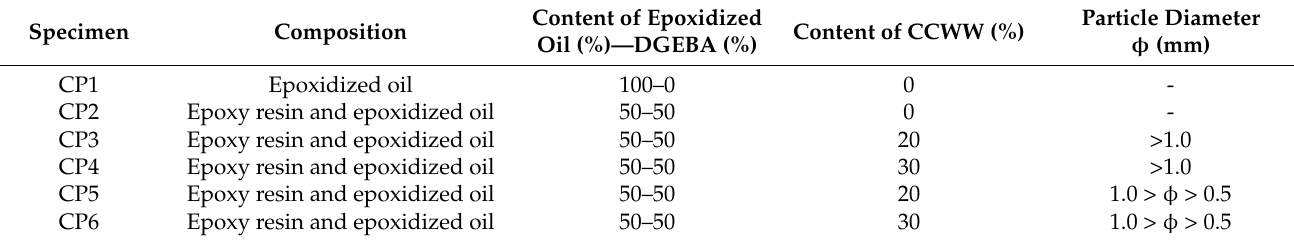
Table 1. Planning and experimental conditions for the preparation of